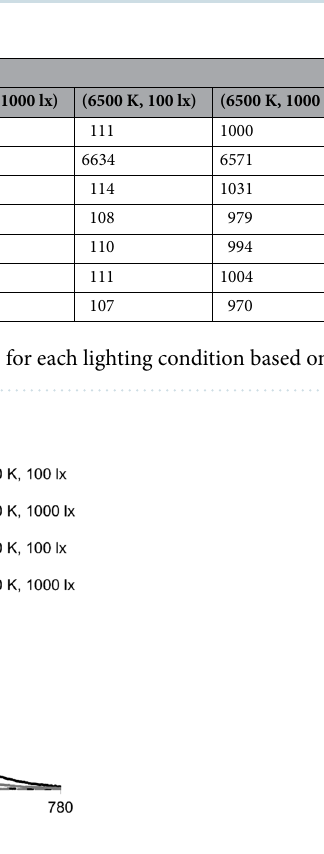
Figure 1. Spectral power distribution was measured at eye level in the four lighting